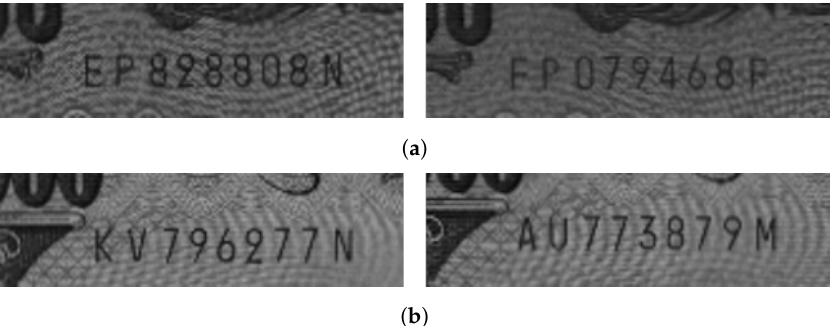
Figure 8. Typical images from set A. ( a ) 1000 Yen ( b ) 5000 Yen.